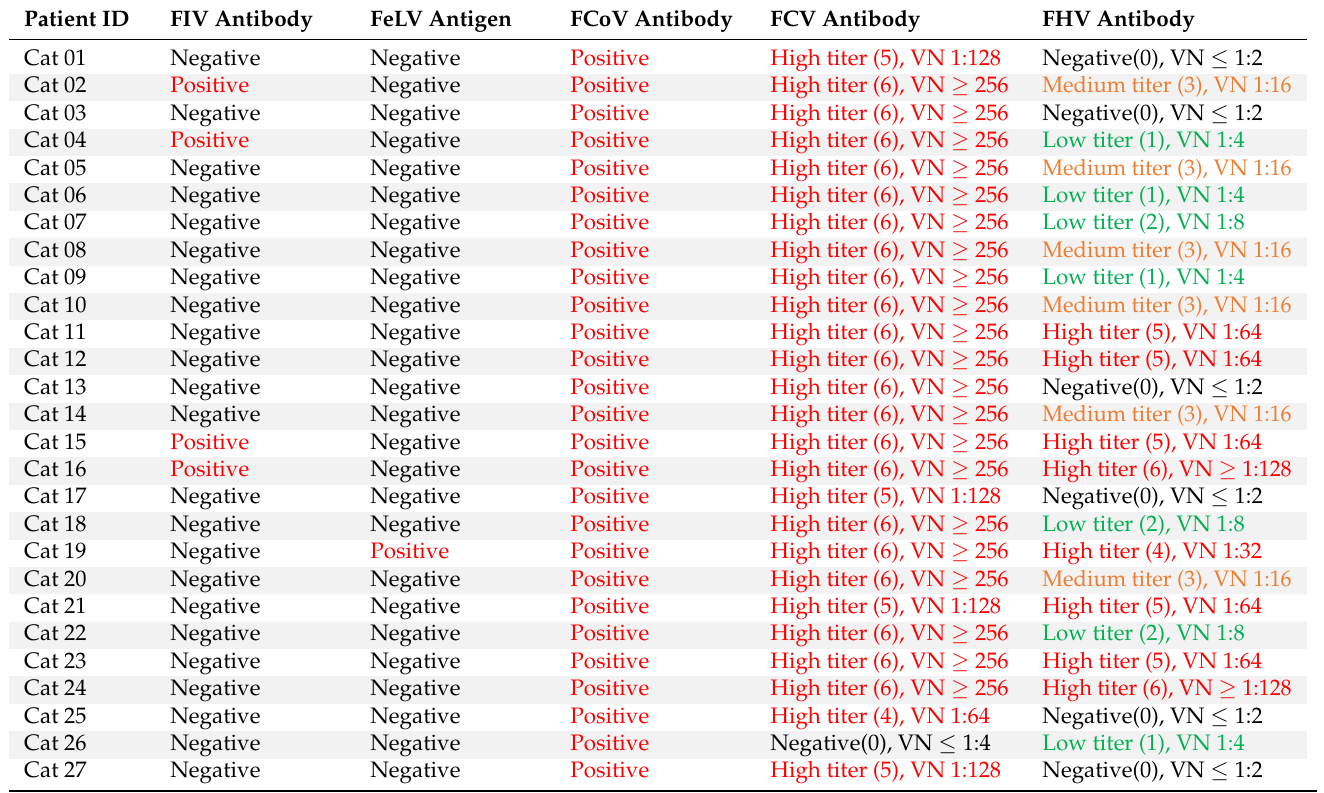
Values inside the brackets (n) indicate scale of the antibody titer; values in red color indicate high antibody titer or positive result for a qualitative snap test; values in brown color indicate medium antibody titer; values in green color indicate low antibody